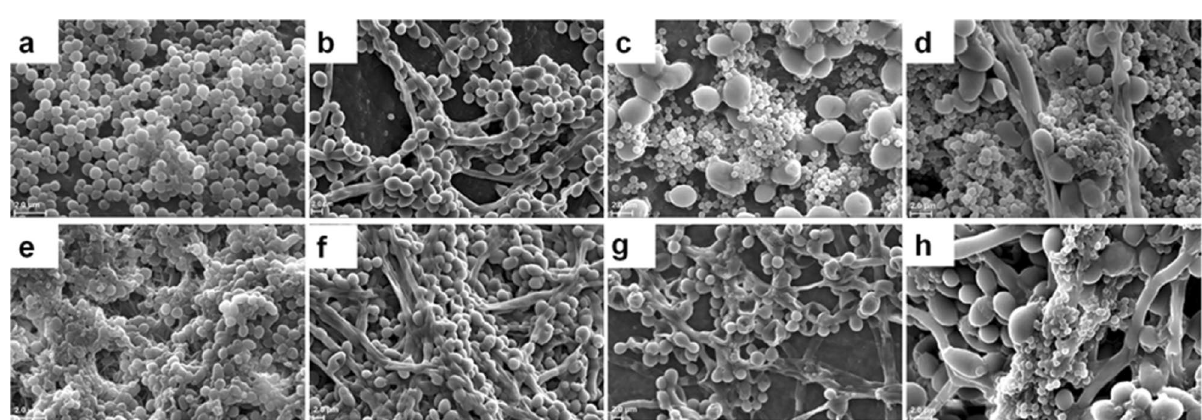
Figure 4. Visualisation of monomicrobial and polymicrobial biofilms of S. aureus and C. albicans on human cadaveric cornea using Scanning Electron Microscopy. S. aureus biofilm at 24 h ( a ), C. albicans biofilm at 24 h ( b ), polymicrobial mixed biofilm of S. aureus and C. albicans grown simultaneously for 24 h ( c ), preformed biofilm of S. aureus for 24 h to which C. albicans was added, ( d ) S. aureus biofilm at 48 h ( e ), C. albicans biofilm at 48 h ( e ), polymicrobial mixed biofilm of S. aureus and C. albicans grown simultaneously for 48 h ( g ) and preformed biofilm of C. albicans for 24 h to which S. aureus was added ( h